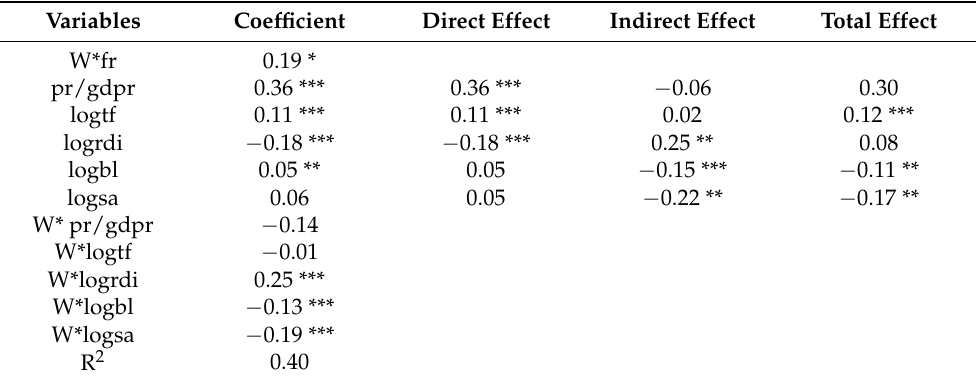
Table 7. Results of the SDM with spatial fixed effects for the eastern region in China.